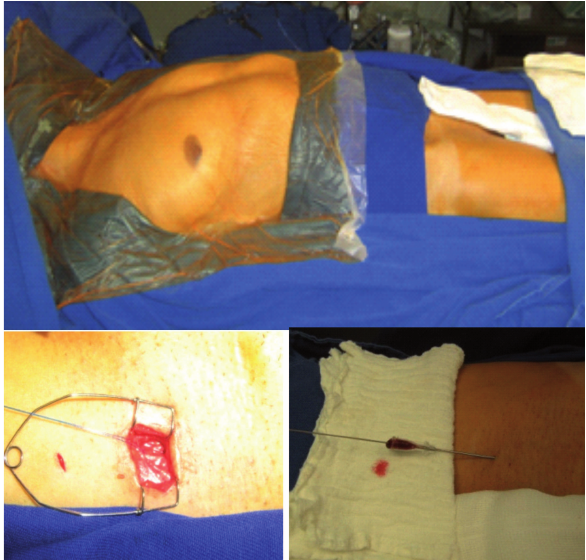
Fig. 1 - Posição cirúrgica e acessos periféricos. Acima: posição de decúbito dorsal com leve elevação do hemitórax direito e exposição dos vasos femorais. Esquerda: Dissecção mínima da artéria femoral esquerda (afastador de íris), para introdução da cânula arterial. Direita: Punção femoral para passagem percutânea da cânula venosa